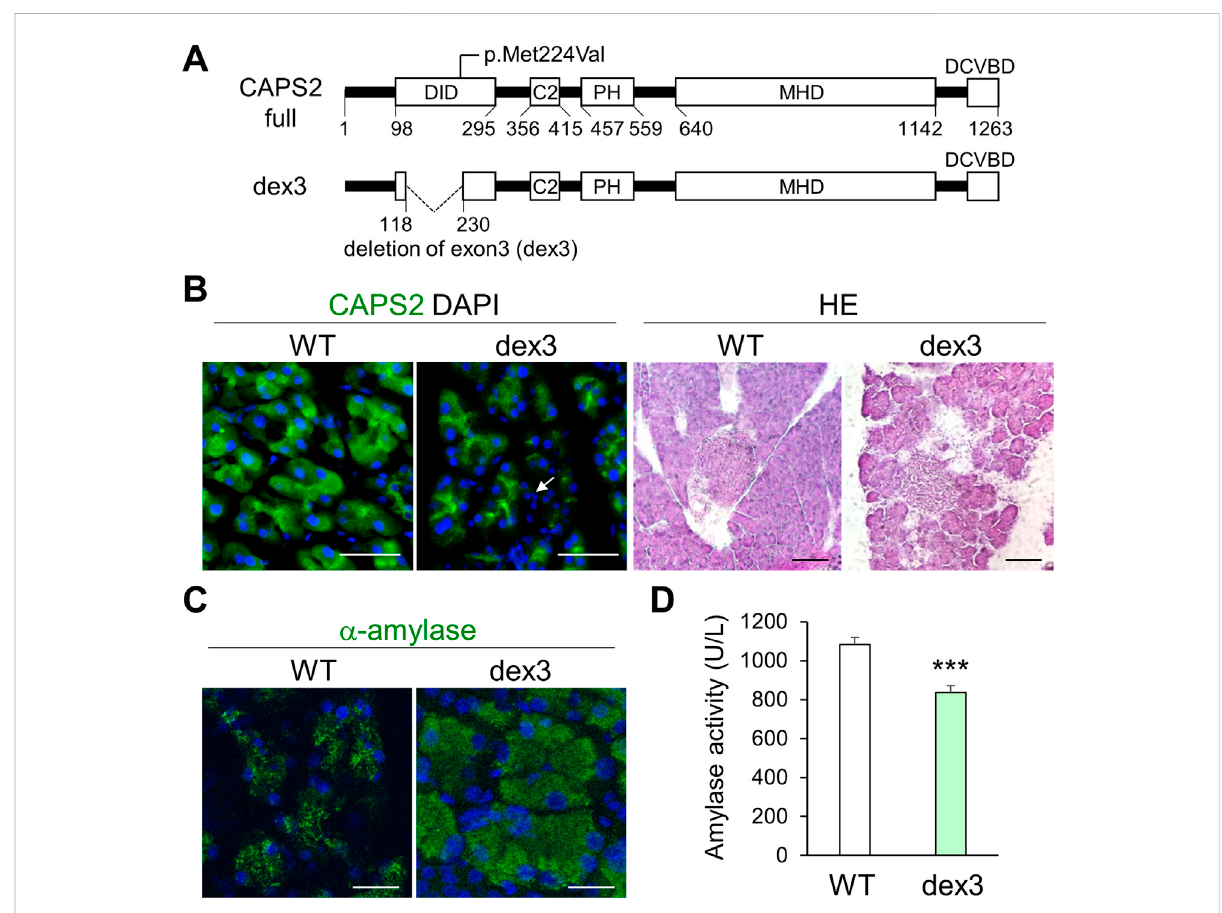
FIGURE 7 Pancreatic acinar cell degeneration and abnormal pancreatic exocrine function in mice with Cadps2 exon3 (dex3) deletion. (A) , Cadps2 gene structure of dex3 mice speci fi cally expressing a rare alternative splicing variant Cadps2-dex3 (deletion of exon 3) identi fi ed in patients with autism spectrum disorder.A human variant p. Met224Val identi fi edin apatientwith CP ismappedto exon3 which is located within the dynactin-interacting domain (DID). Cadps2-dex3 mice have a deletion of exon3 in the Cadps2 gene. Exon3 (119 – 229 aa); DID, dynactin-interacting domain; C2, C2 domain; PH, pleckstrin homology domain; MHD, Munc13 homology domain; DCVBD, dense-core vesicle binding domain. (B) , CAPS2- immunostaining ( green ) of pancreatic acini and HE-staining of pancreatic tissues in WT and dex3 mice. DAPI staining ( blue ) for nuclei. An arrow indicates increased interstitial cells between pancreatic acini in dex3 mice. Scale bars: 50 μ m in immunostaining and 100 μ m in HE-staining images. (C) , α -amylase (green) immunostaining images of WT and dex3 mice. DAPI staining ( blue ) for nuclei. Scale bars: 25 μ m. (D) , α -Amylase activity in the serum of 18-week-old WT and Cadps2-dex3 mice (U/L; average ±SEM): WT ( n = 10) 1084.07 ± 36.03, dex3 ( n = 10) 836.13 ± 35.69, Student ’ s t -test: * p =